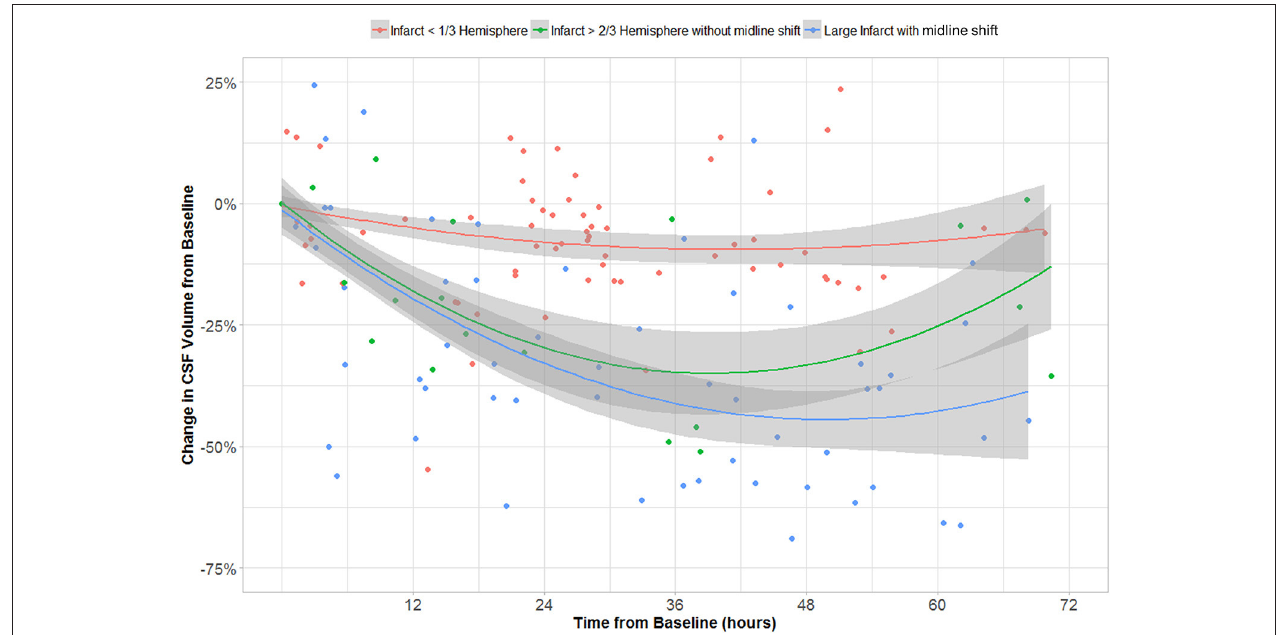
FIGURE 8 | CSF volume (as percentage of volume on baseline CT) over time in groups with CED grades 0–1, 2, and